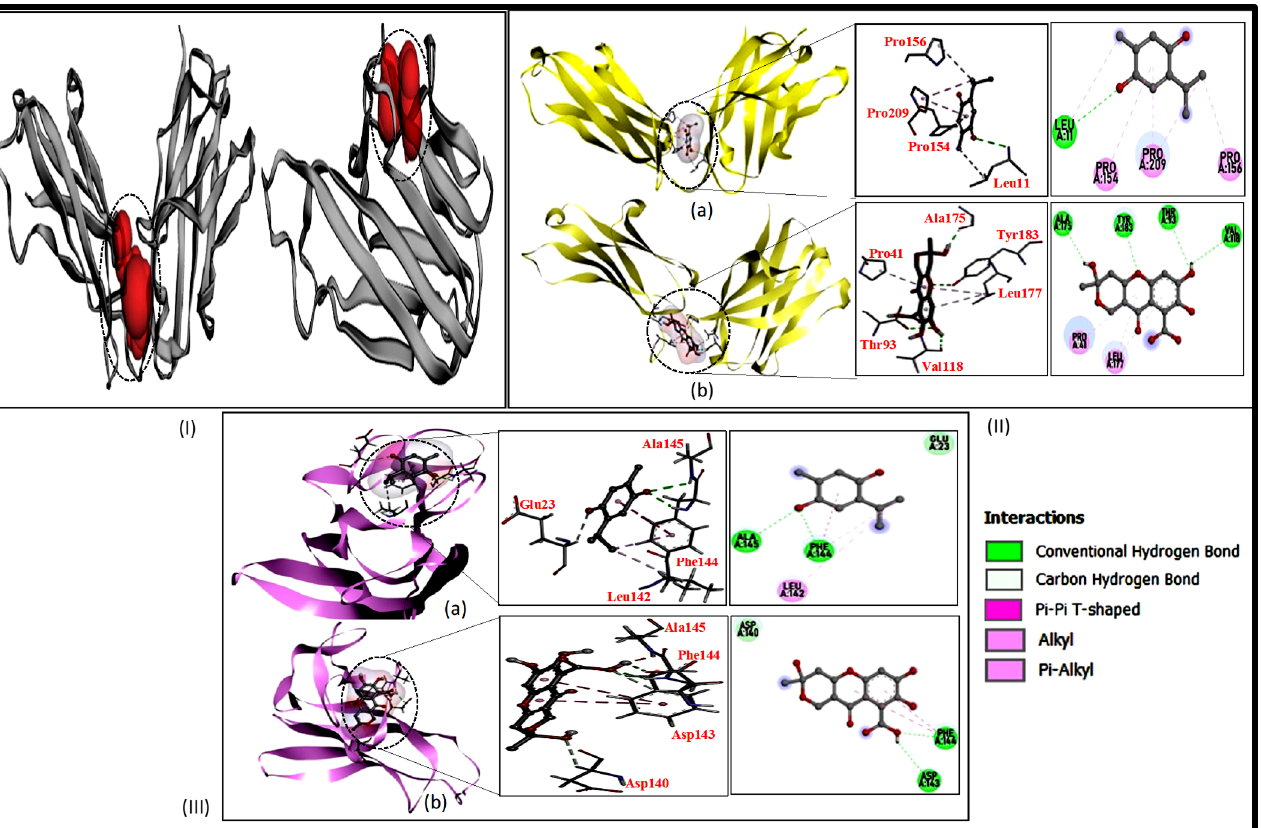
Figure 1 . ( I ) The binding pocket (red cartoon with dotted line) of 4CNI and 6RMJ. ( II ) The 3D interaction of IL-6 (4CNI) with TQ (a) and FA (b). ( III ) Cartoon representation showing the hydrogen bond interaction of TNF (6RMJ) with TQ (a) and FA (b). Table 1 . Docking score, hydrogen, and hydrophobic interaction of ligands with target receptors .